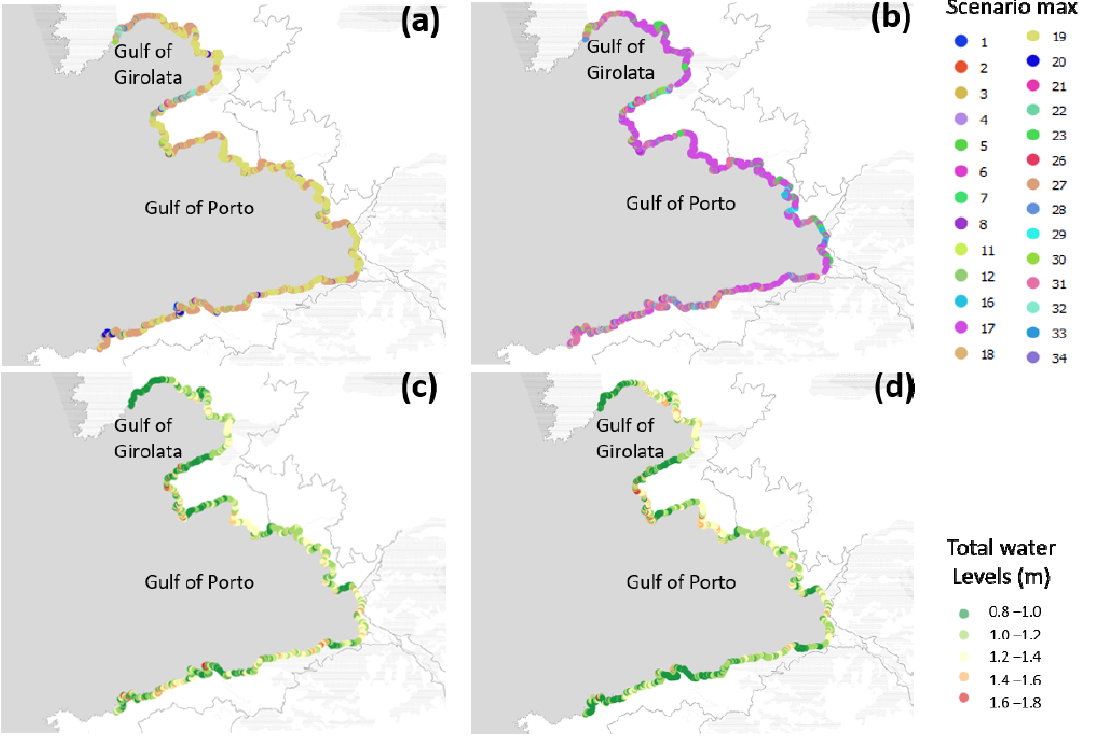
Figure 10. Scenarios leading to maximal water level at the shoreline in Gulf of Porto and Gulf of Girolata: ( a ) for directions Dp = 270° and Du = 240°; ( b ) for directions Dp = 240° and Du = 240° in current conditions. Total water level at the shoreline obtained in Gulf of Porto and Gulf of Girolata: ( c ) for directions Dp = 270° and Du = 240°; ( d ) for directions Dp = 240° and Du = 240° in current conditions.